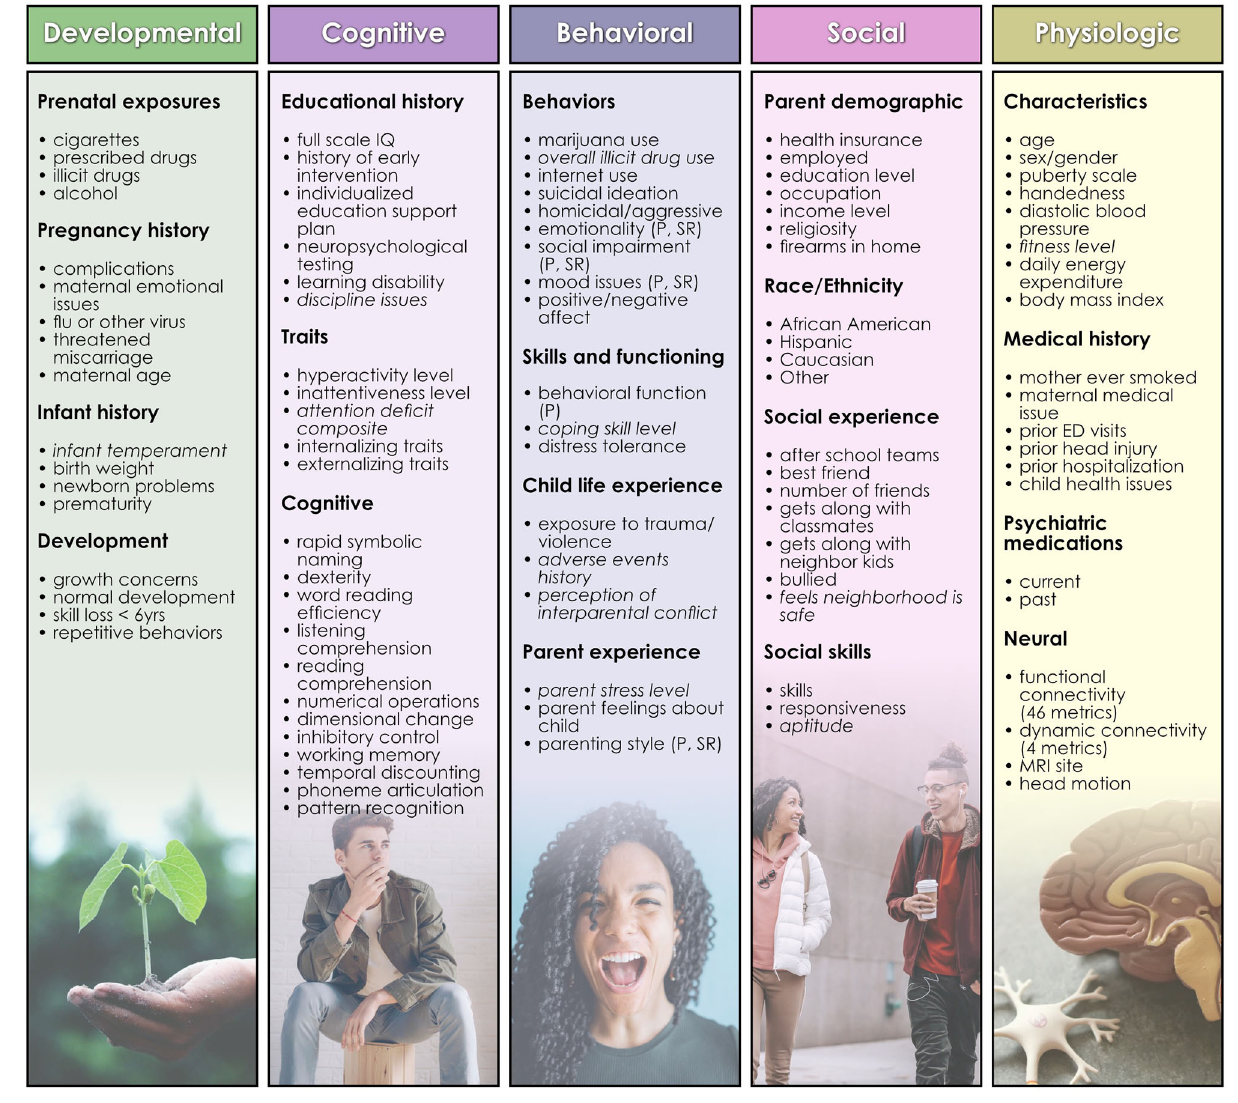
using standard algorithms in SPM12